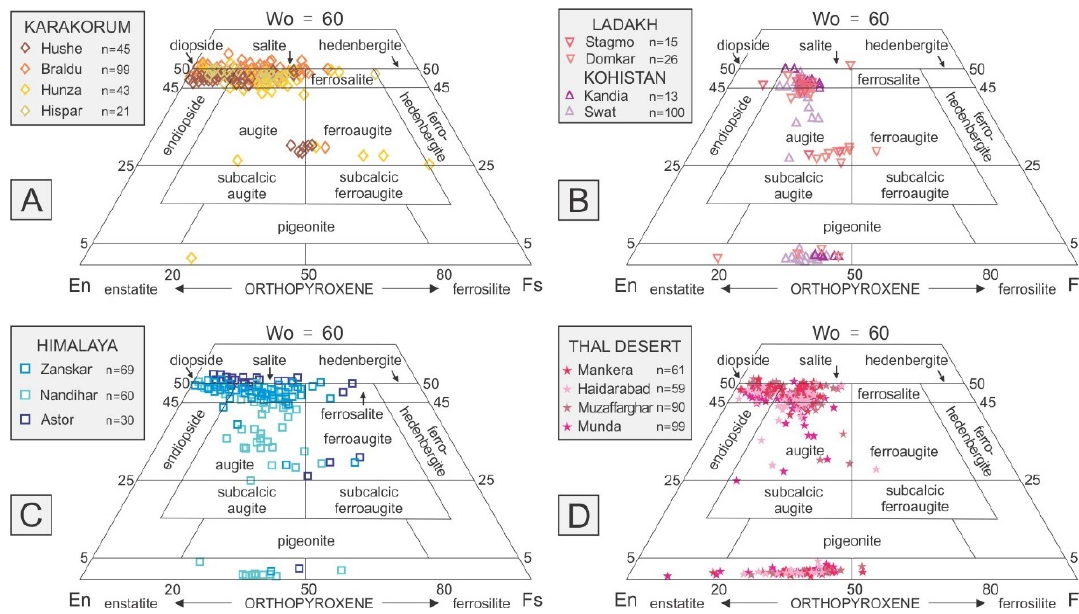
Figure 6. Chemical composition of detrital pyroxene in river sands of northern Pakistan ( A = Karakorum, B = Ladakh and Kohistan arcs, C = Himalaya) and in the ( D ) Thal Desert. Pyroxene quadrilateral from Poldervaart and Hess [128] and Morimoto et al. [125]. Wo: Wollastonite (Ca 2 Si 2 O 6 ); En: enstatite (Mg 2 Si 2 O 6 ); Fs: ferrosilite (Fe 2 Si 2 O 6 ).